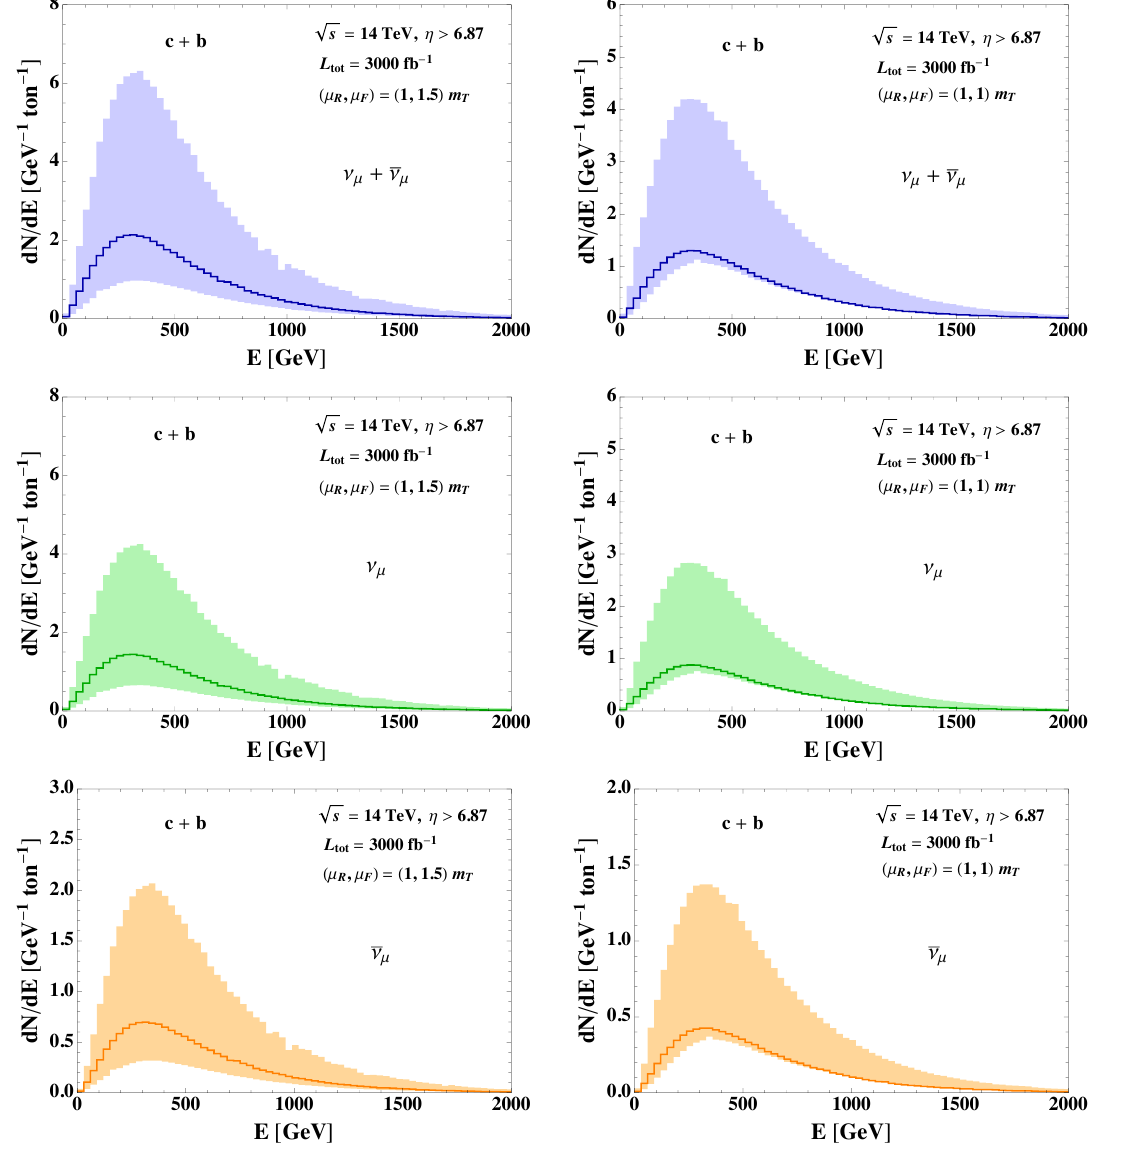
Figure 10 . Uncertainty range due to the QCD scale variation in the muon neutrino and antineu- trino number of charged current events per GeV per ton as a function of the incident neutrino energy for neutrinos with pseudorapidity (cid:17) > 6 : 87 generated by heavy-(cid:13)avor decays in pp collisions p with s = 14 TeV and integrated luminosity L = 3000 fb (cid:0) 1 . The central predictions are obtained using as input ( (cid:22) R ; (cid:22) F ) = (1 ; 1 : 5) m T (left) and ( (cid:22) R ; (cid:22) F ) = (1 : 0 ; 1 : 0) m T (right), respectively. The upper and lower limits in each panel arise from 7-point scale variation in the same range as in (cid:12)gure 1.